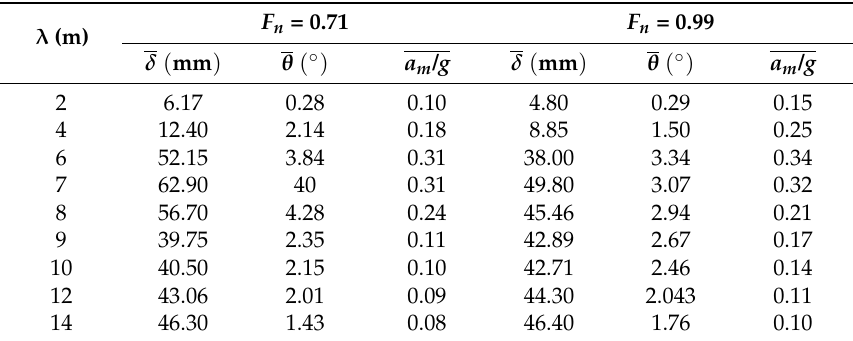
Table 3. Calculated values of various amplitude